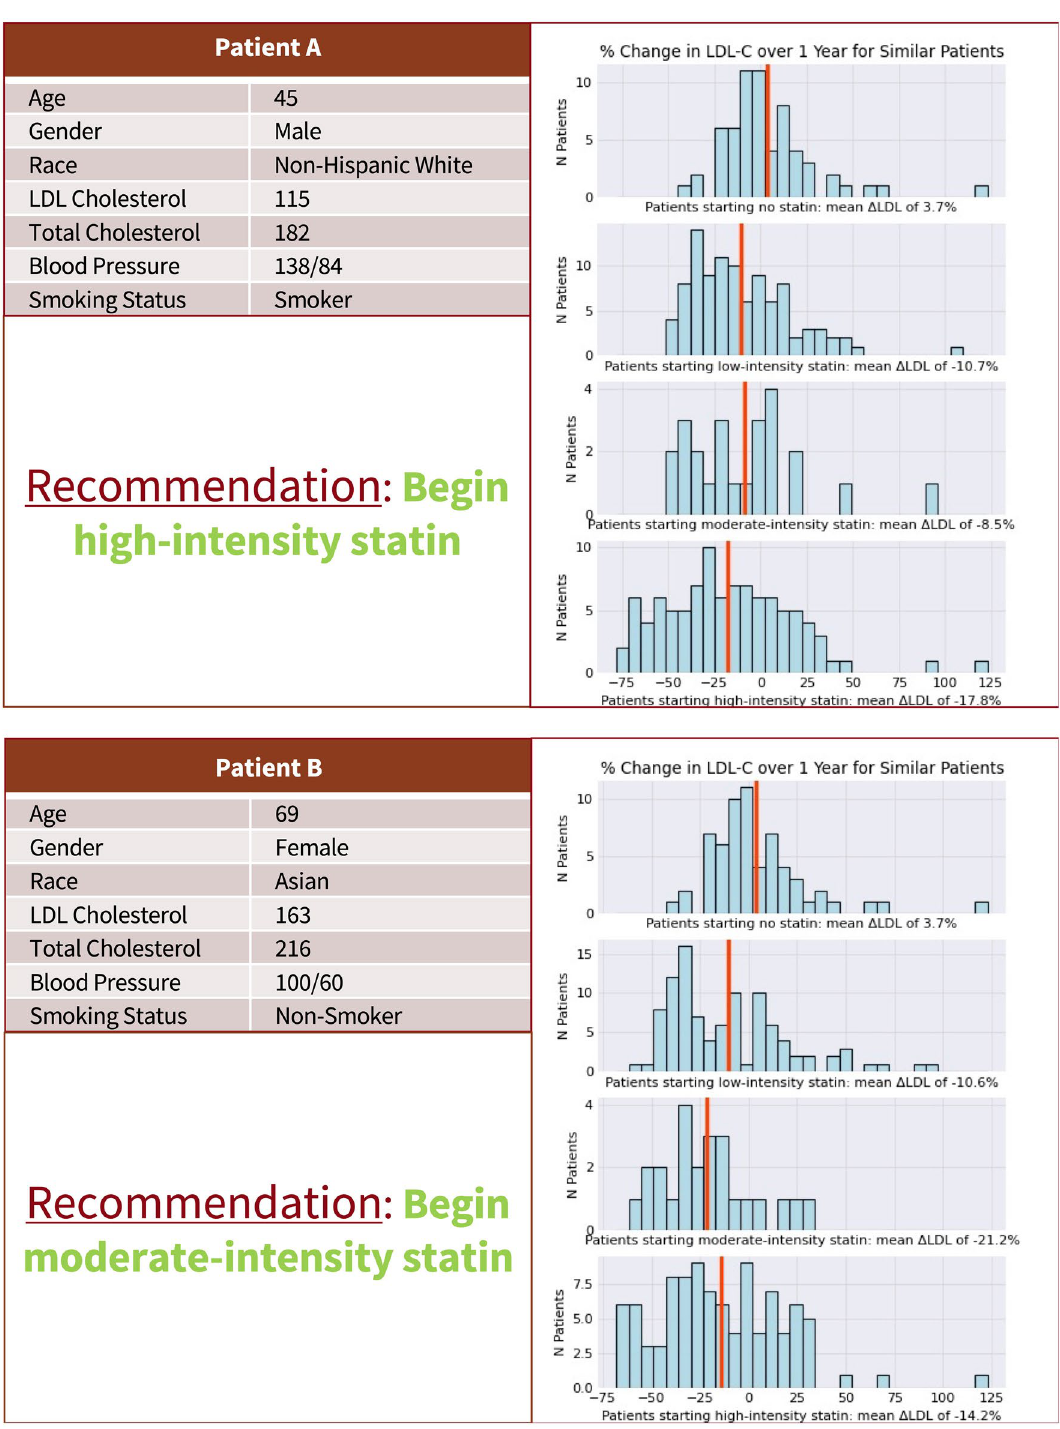
Figure 3. Examples of personalized statin recommendations. Sample recommendations are visualized for patients who were recommended high-intensity therapy ( A ) and moderate-intensity therapy ( B ) based on optimal relative LDL-C lowering across different lines of statin therapy in similar patients, determined through weighted-K-nearest-neighbor regression models. Selected, common baseline patient characteristics are described alongside each recommendation for identification purposes. LDL-C Low density lipoprotein, ΔLDL-C Change in